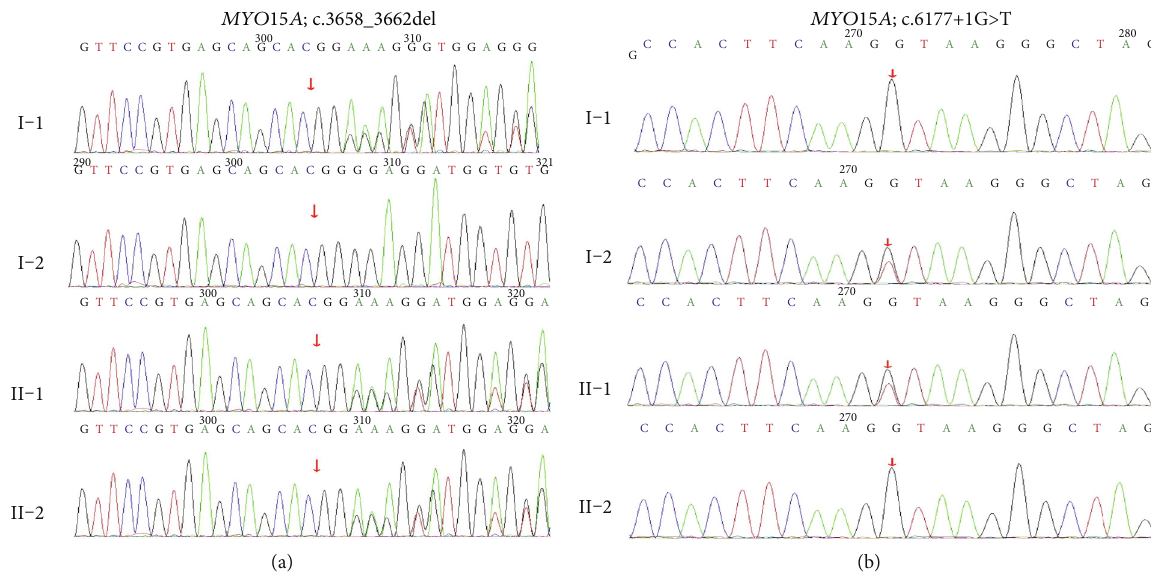
Figure 3: Sanger sequencing results of the c.3658_3662del and c.6177+1G > T mutations in the family